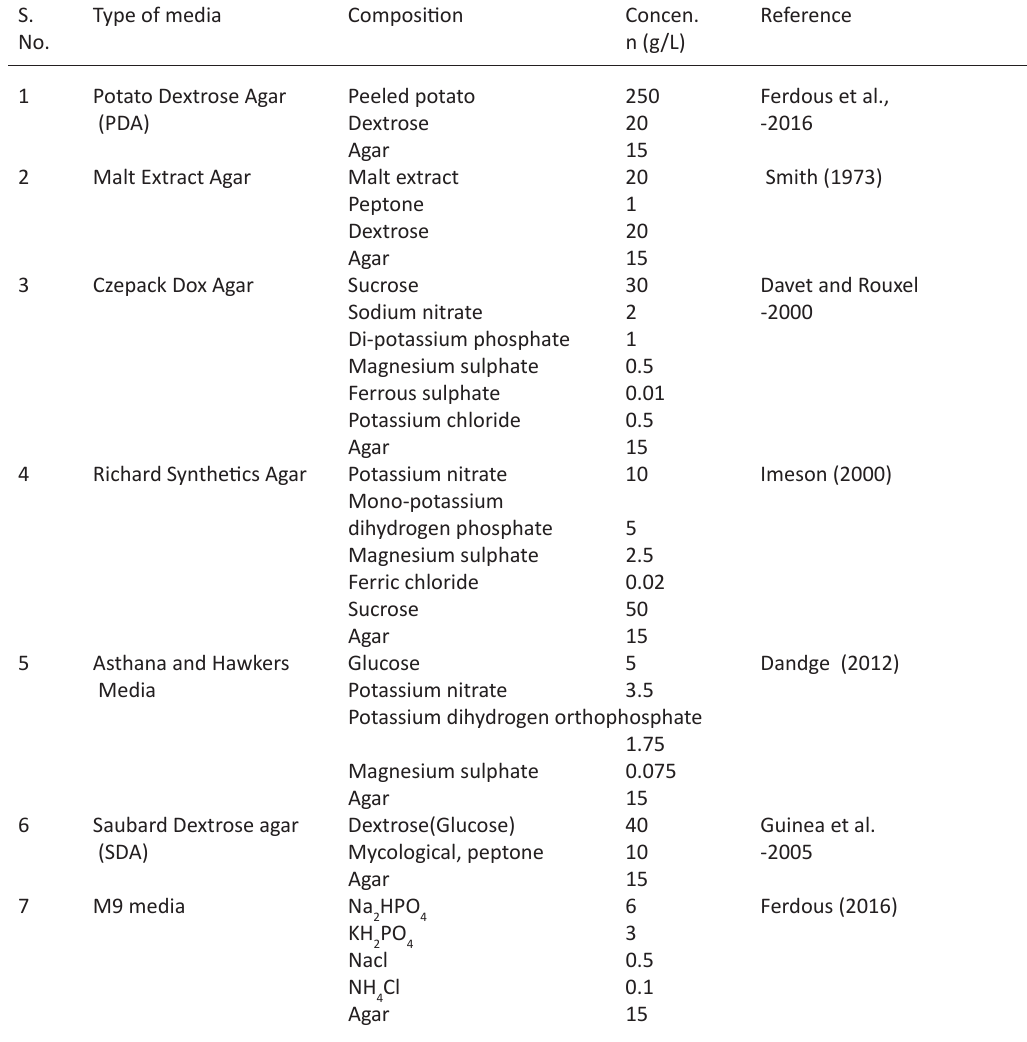
Table 1. Different media exploited for the optimal growth of TA and TV strains S. Type of media